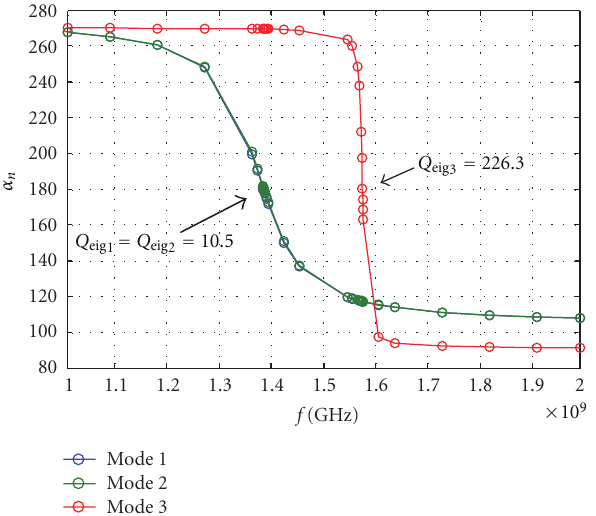
Figure 18: Resonant frequencies for di ff erent